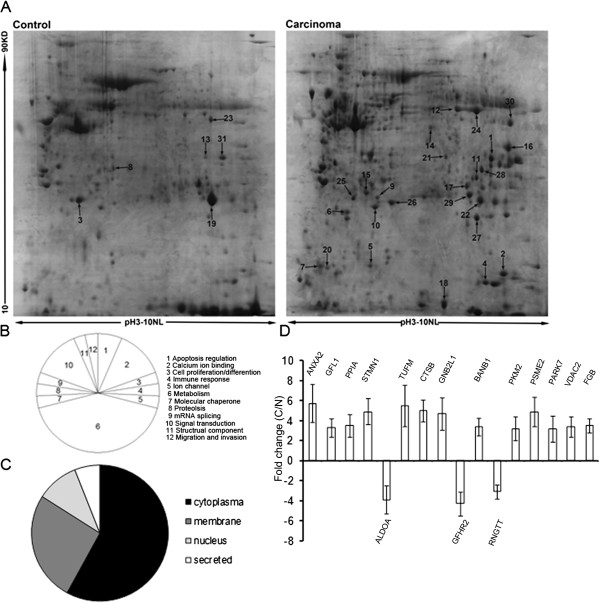
Representative 2-DE gel images of lung SCC and adjacent normal tissues. (A) Fresh human lung SCC and paired adjacent normal tissues of Asian population were obtained from 8 patients suffering lung SCC who underwent surgical resections. Total protein extracts were separated on pH 3–10 nonlinear IPG strips in the first dimension followed by 12% SDS-PAGE in the second dimension and visualized by CBB staining. The arrows indicate the 31 differentially expressed proteins. (B) Cluster analysis of the changed proteins revealed that the altered proteins were involved in different biological processes, including metabolism (40%), calcium ion binding (13%), signal transduction (13%) and so on. (C) The identified proteins were categorized into four groups according to their subcellular locations. 58% of the total proteins were located in the cytoplasm, and the remainder was situated in the nuclear (26%), cell membrane (10%) and secreted protein (6%). (D) Expression profile of the 16 altered proteins (3-fold change) as shown in Figure 1A. The intensities of spots were quantified using PDQuest 2-D analysis software.